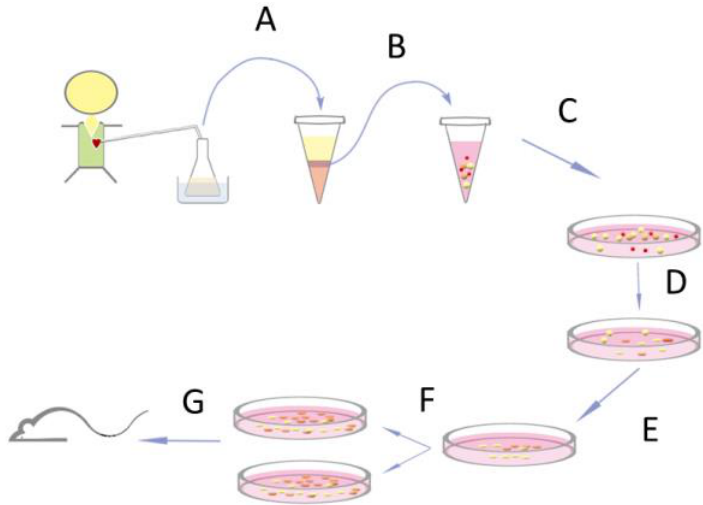
Figure 1. Schematic drawing of the isolation and expansion procedures for human pericardial e ff usion-derived progenitor cells (PEPCs). ( A ) Drain fluid was collected on the first and second day after open-heart surgery in a drain bottle containing 300 mL of 4 ◦ C normal saline. The bottle was kept at 4 ◦ C during collection. ( B ) Mononuclear cells were collected by density gradient centrifugation with Ficoll-Paque. ( C ) The mononuclear cells with red blood and white blood cells were plated on a fibronectin-coated plate and cultured in cardiosphere medium. ( D ) The red blood and white blood cells were removed by serial medium supplement every 3 days. ( E ) Spindle-like cells were noted as early as 3 days while cardiospheres appear around 7 days after seeding. ( F ) Further cell expansions to obtain su ffi cient cell number for transplantation. ( G ) PEPCs were injected into peri-infarction regions of a mouse